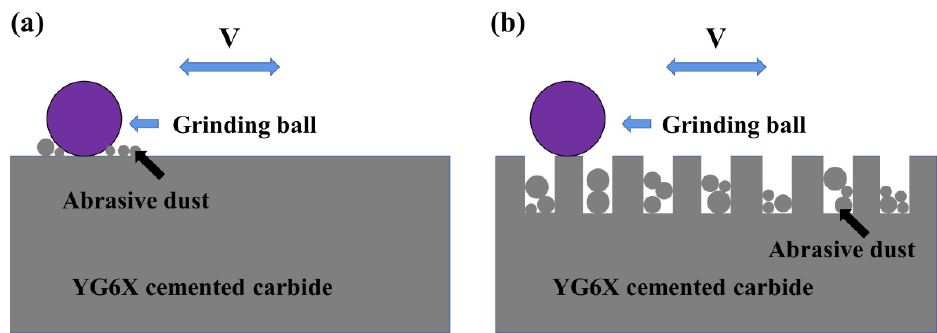
Figure 10. Wear mechanism analysis of the ( a ) smooth surface and ( b ) textured surface.